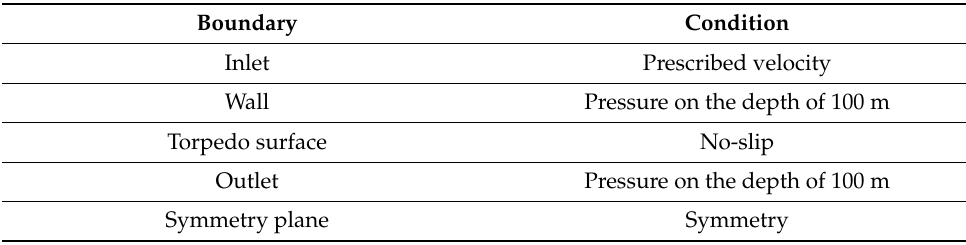
Table 2. Boundary conditions used for numerical computation.